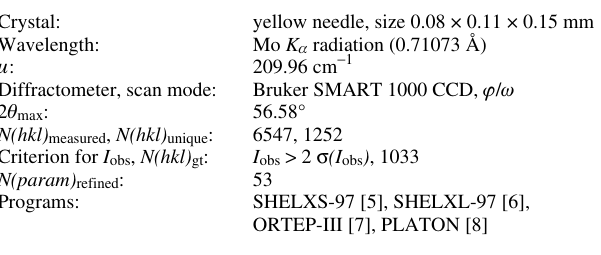
Table 1. Data collection and handling.